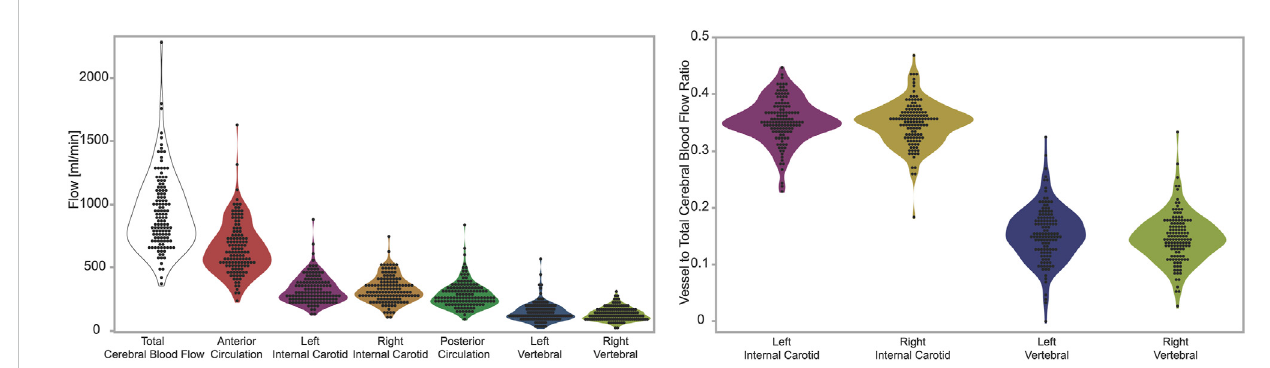
FIGURE 3 Leftpanel:measurementsof fl owinunitsofmlperminute.Fromlefttorightthe fi guresshowstotal,anteriorcirculation,leftinternalcarotid,rightinternal carotid,posteriorcirculation, leftvertebral,rightvertebra.Rightpanel:ratiosof fl owinindividualarteries versus totalcerebralblood fl ow.Fromlefttorightthe fi gure shows left internal carotid, right internal carotid, left vertebral, right vertebra. The fi gures demonstrate visually (1) the range of total cerebral blood fl ow, (2) the contribution from individual arteries is predominantly from the anterior circulation, that fl ow through (3) carotid and (4) vertebral arteries are symmetric on the left and right